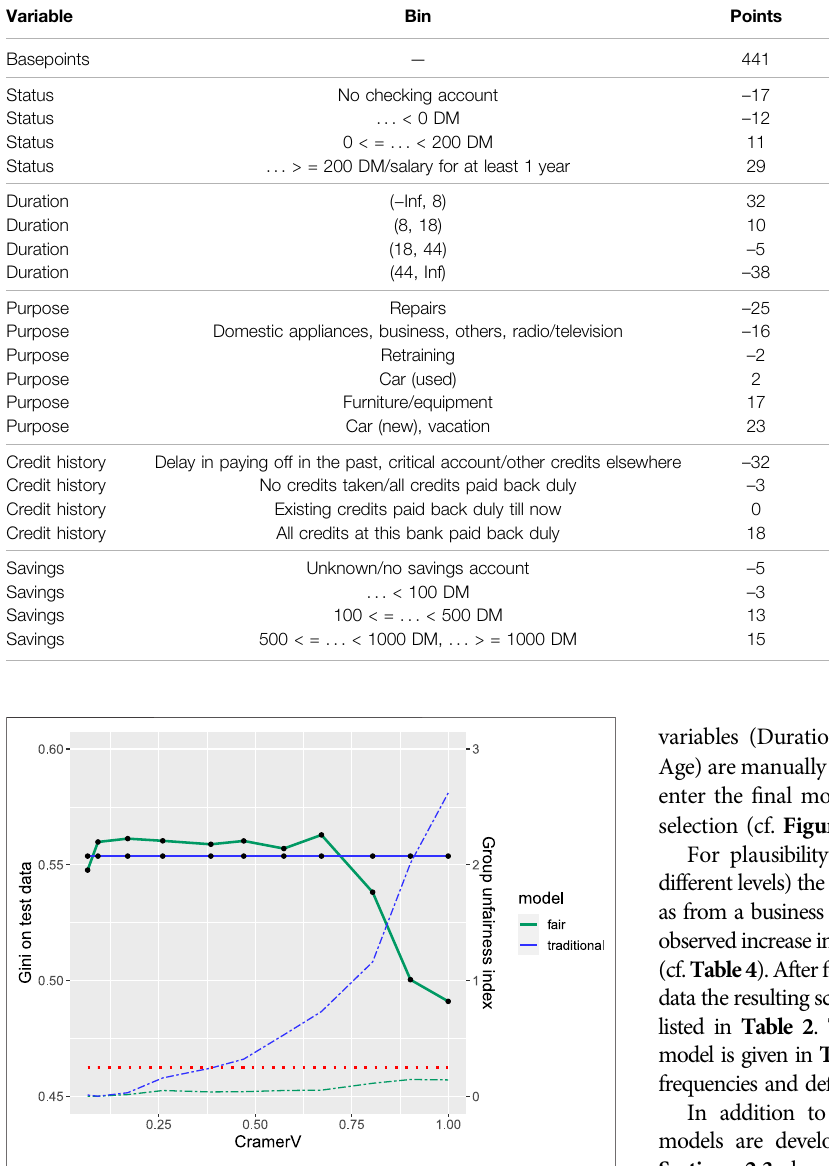
FIGURE 2 | Fairness-performance trade-off: performance (solid) and unfairness (dashed) for traditional (blue) and fairness-corrected (green) model for different levels of correlation between the protected variable gender and the prediction variable status. The red dotted line indicates the thumb rule for